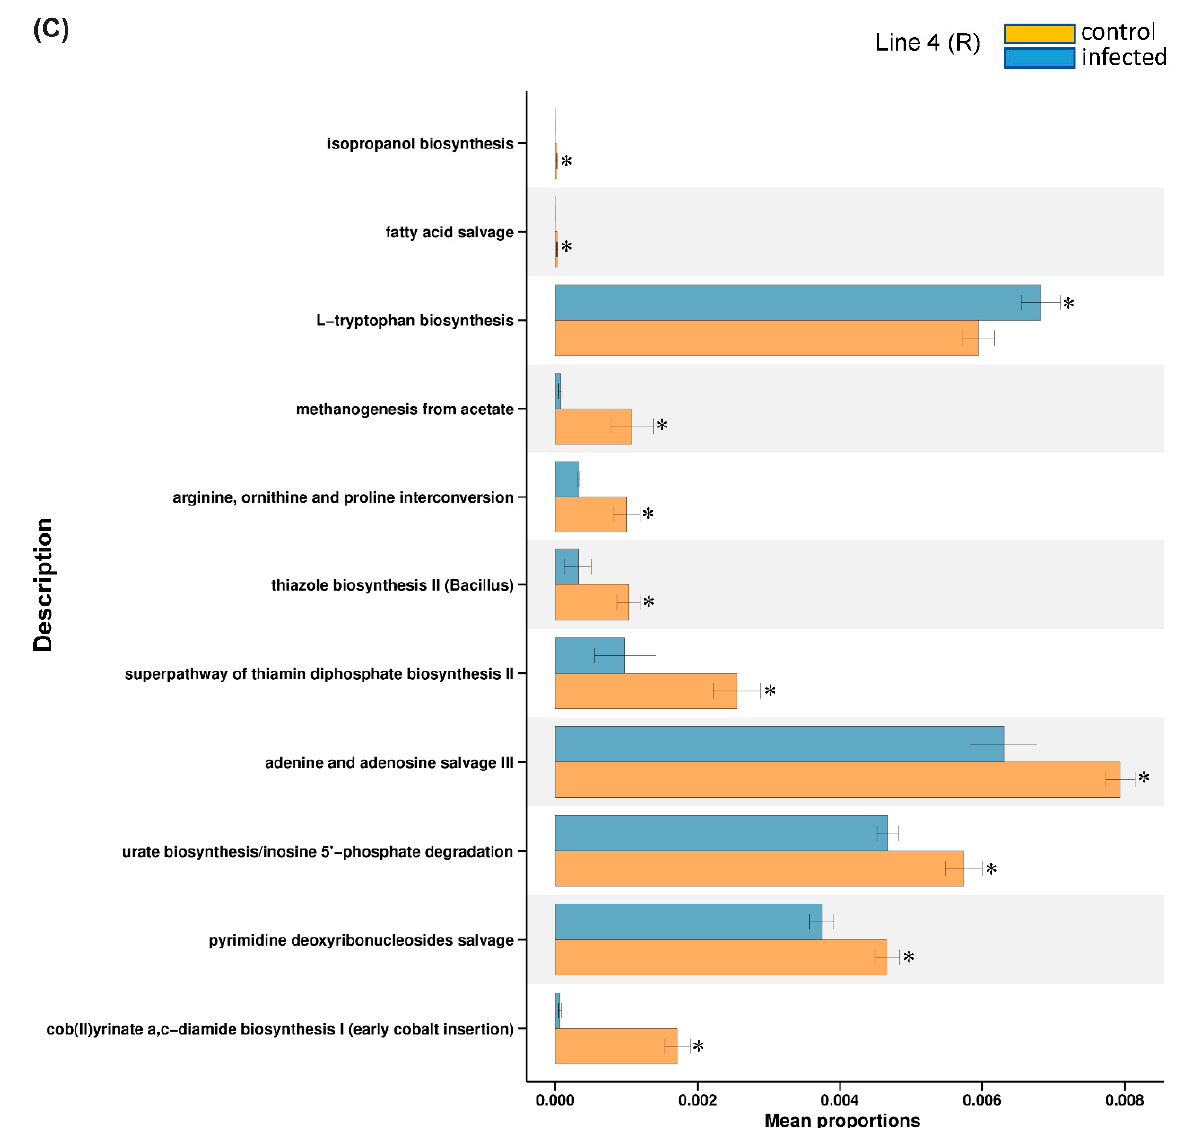
Figure 7. KEGG modules associated with leaf bacteria that were significantly different (* p < 0.05) between uninfected control ( C ) and beet curly top virus (BCTV)-infected sugar beet genotypes ( A ) Line 19 (susceptible; S); ( B ) Line 13 (resistant; R); and ( C ) Line 4 (resistant; R) at 4 weeks post inoc- ulation (wkpi). Data are mean ± standard error of four replicates (uninfected control) and five replicates (infected).